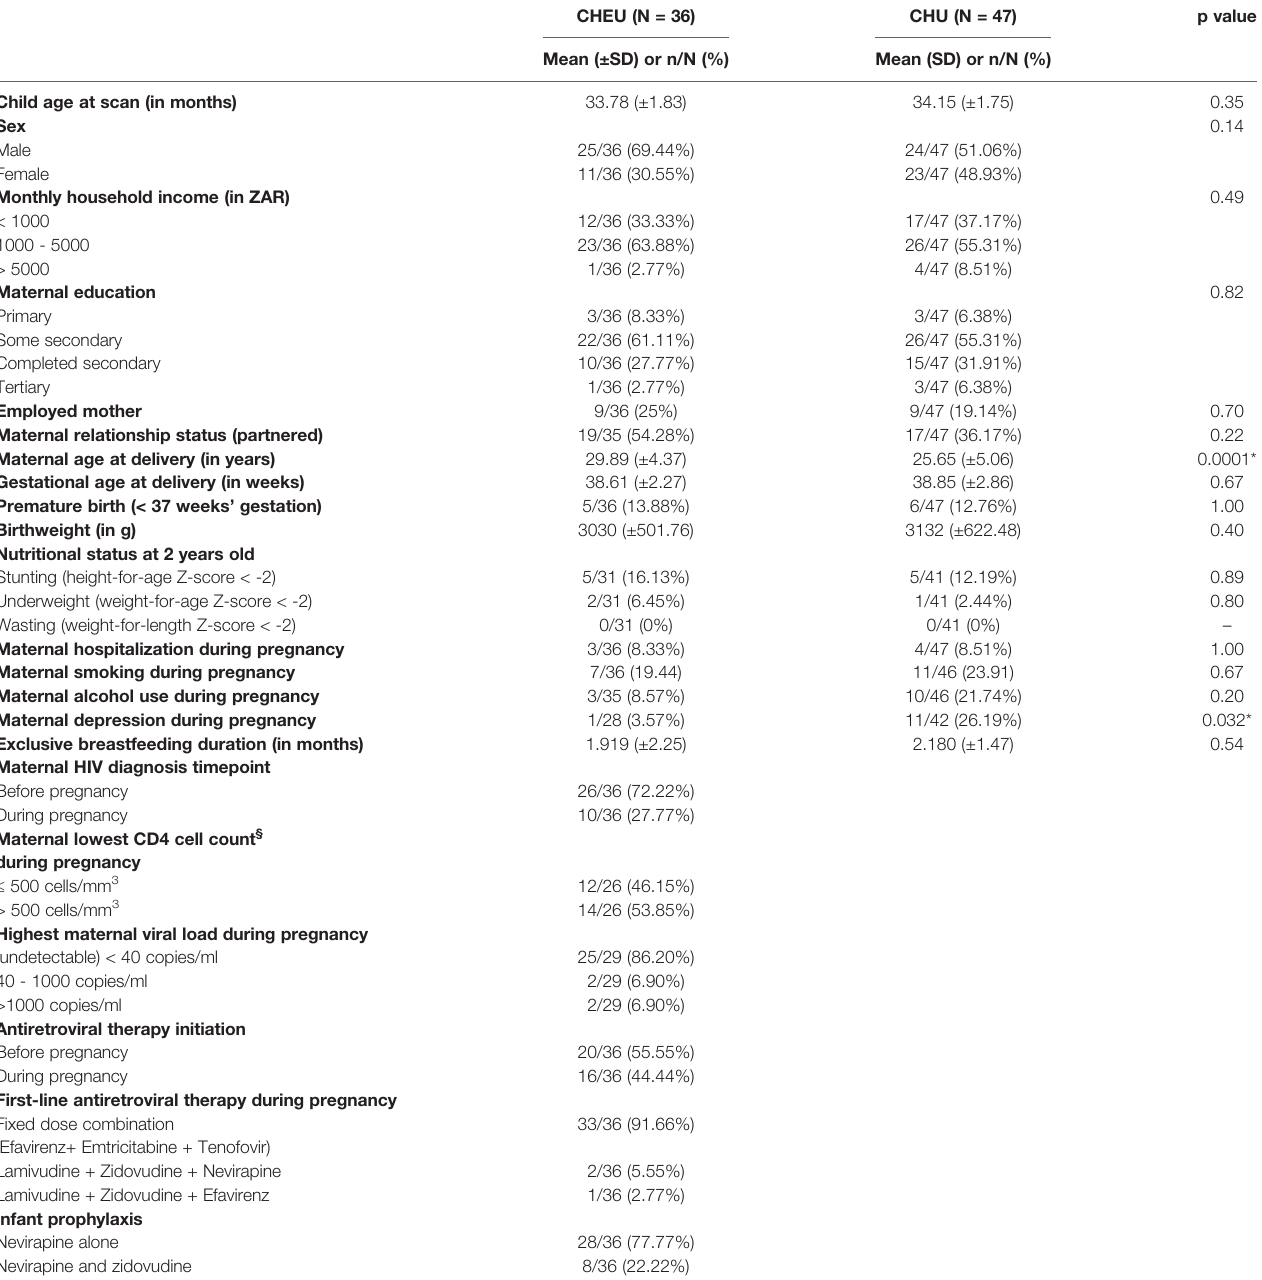
TABLE 1 | Sociodemographic characteristics of children included in the MRS complete-case analysis, according to HIV